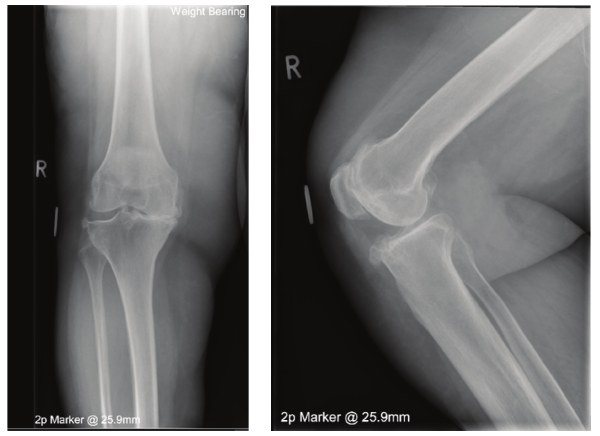
Figure 2: Postoperative AP and lateral radiographs of right Colum- bus